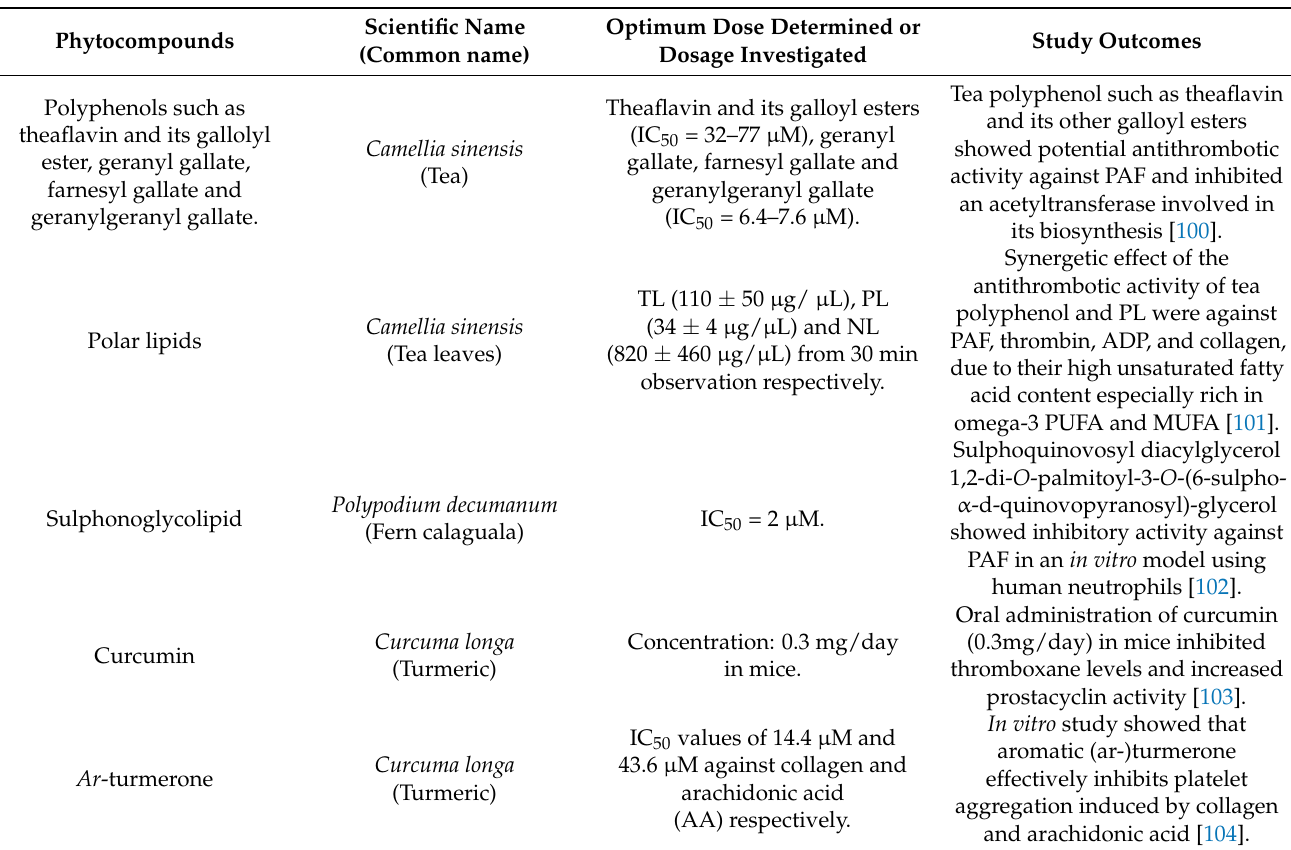
Table 1. Comparison of different studies investigating phytocompounds and their antithrombotic activities against PAF andother platelet